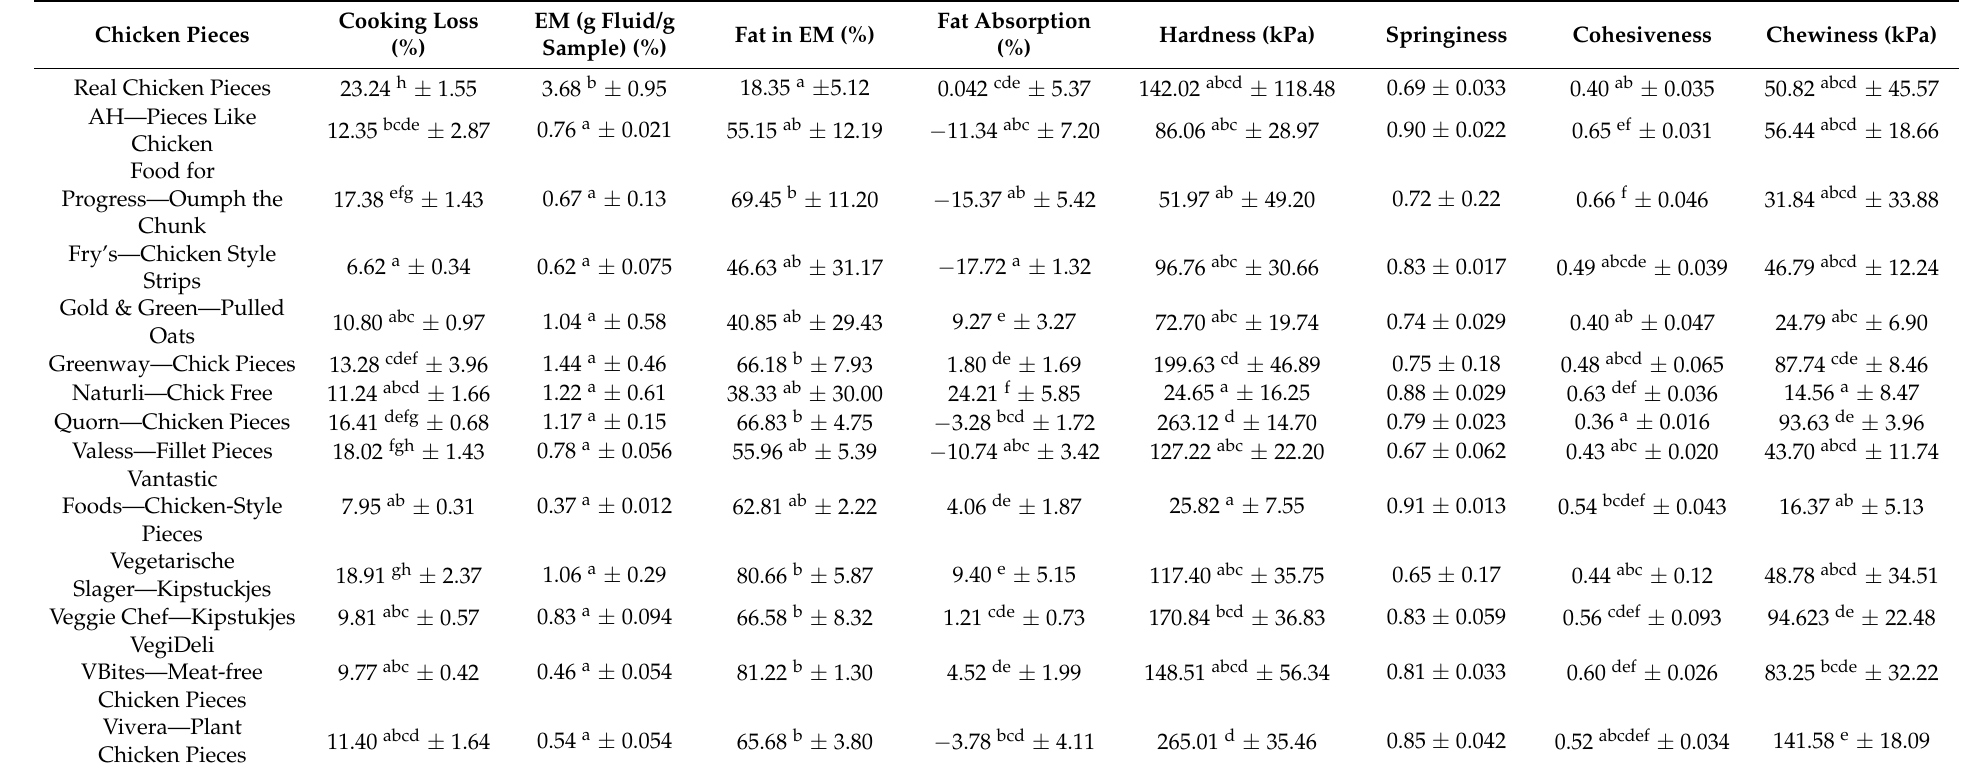
Table 3. Instrumental properties measured for the meat analogues studied in the present